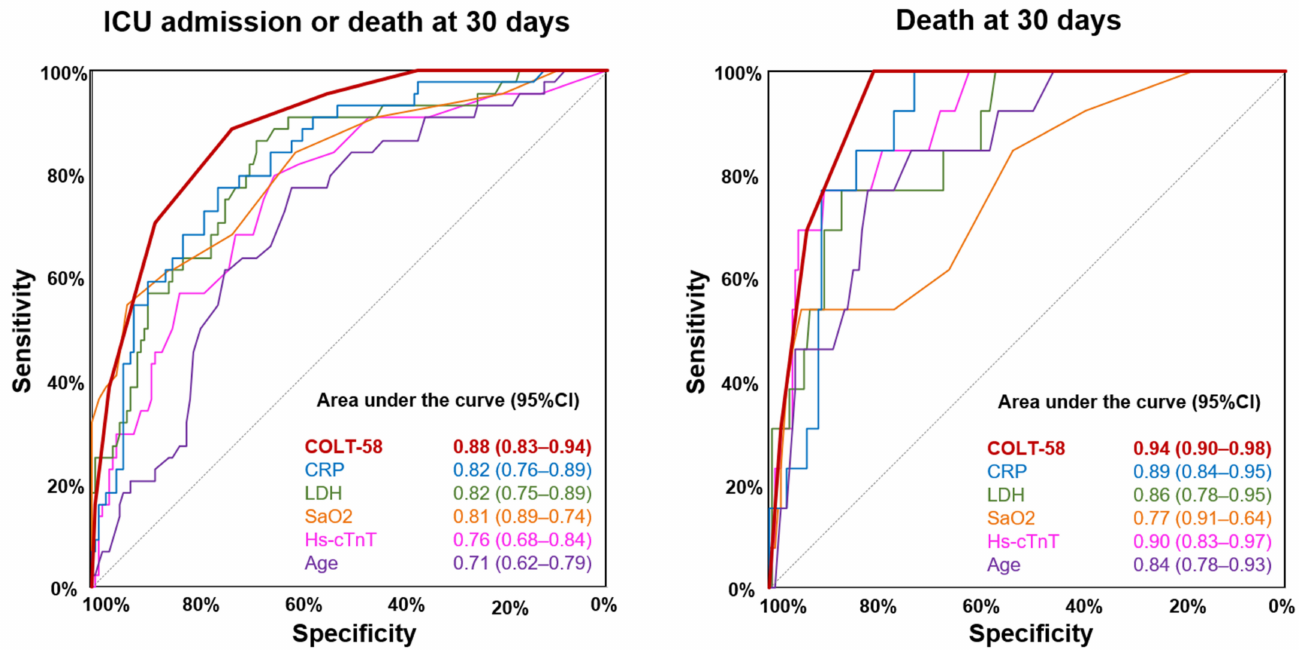
Figure 3. Predictive performance of the COLT-58-Score and its components in COVID-19. Left panel shows the AUROC for the primary composite outcome consisting of ICU admission and death at 30 days for the COLT-58-Score, CRP, LDH, SaO2, hs-cTnT, and age in COVID-19; Right panel shows the AUROC for death at 30 days for the COLT-58-Score, CRP, LDH, SaO2, hs-cTnT, and age; COVID-19 = coronavirus disease 2019, AUROC = area under the receiver operating characteristic curve, ICU = intensive care unit, CI = confidence interval, CRP = c-reactive protein, LDH = lactate dehydrogenase, SaO2 = blood oxygen saturation, hs-cTnT = high-sensitivity troponin